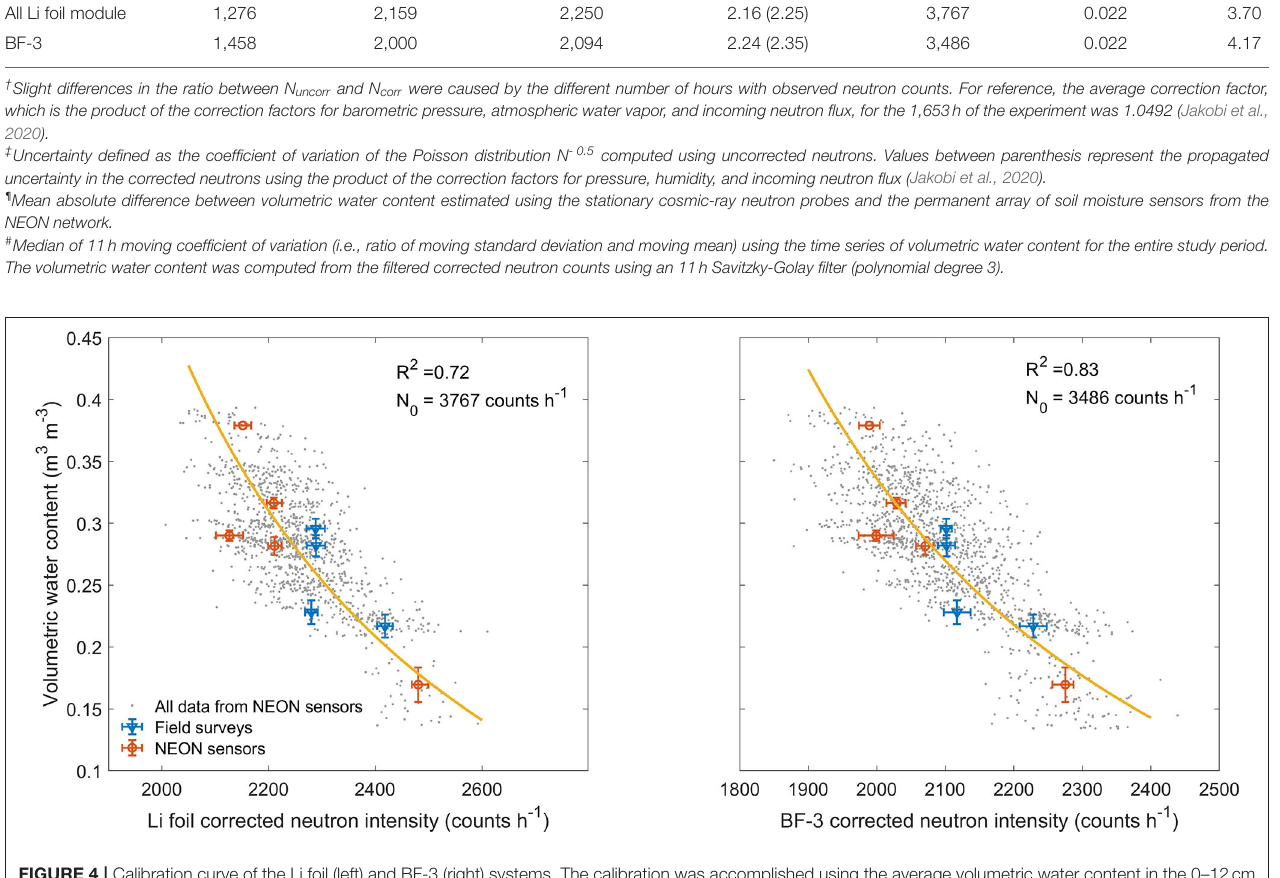
1 standard error of the ±